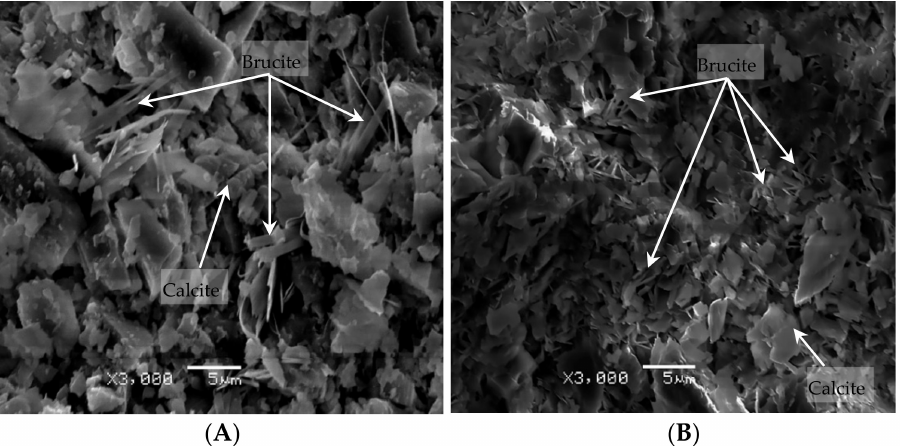
Figure 8. SEM images of reaction products of dolomite powdered compacted bodies: ( A ) Compacted body, NaOH 60 ◦ C 45 days; ( B ) Compacted body, TMAH 60 ◦ C 45